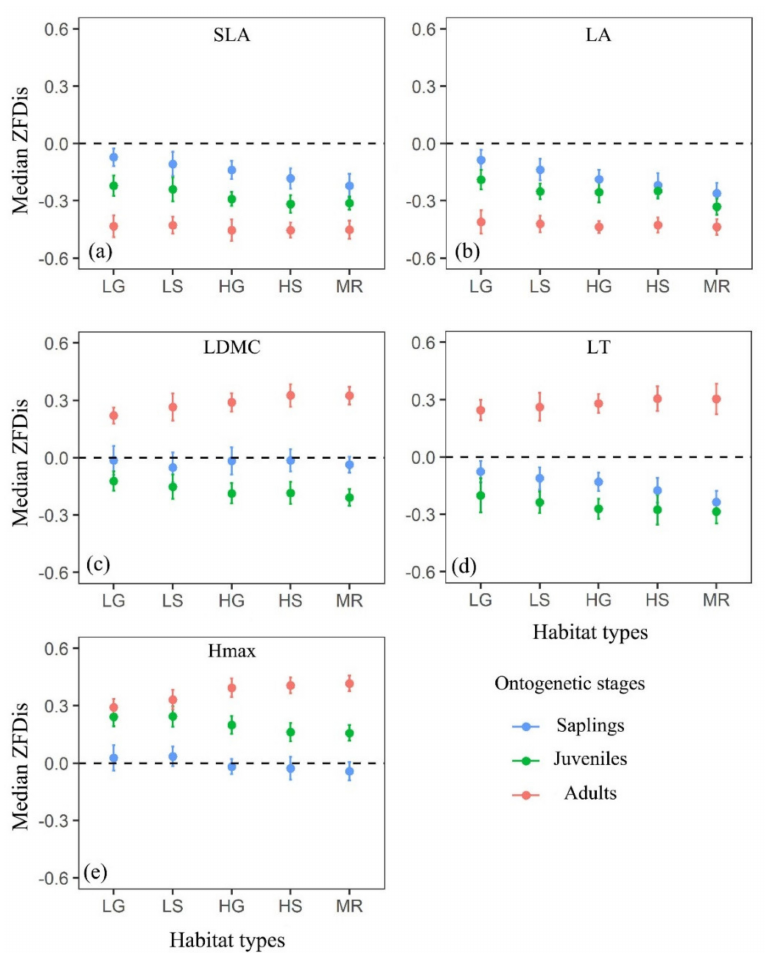
Figure 2. Standardized e ff ect size of functional dispersion (ZFDis) of five functional traits across three ontogenetic stages (saplings, juveniles and adults) and five habitat types at 20 m × 20 m spatial scale. ( a ) SLA: specific leaf area, ( b ) LA: leaf area, ( c ) LDMC: leaf dry matter content, ( d ) LT: leaf thickness, ( e ) Hmax: maximum height, LG: low gully, LS: low slope, HG: high gully, HS: high slope and MR: mountain ridge. Positive median ZFDis indicates functional overdispersion, and so the community assembly is dominated by biotic interactions. Negative median ZFDis indicates functional clustering, and so the community assembly is dominated by environmental filtering. Error bars were 95% confidence intervals, calculated by the Wilcoxon test.